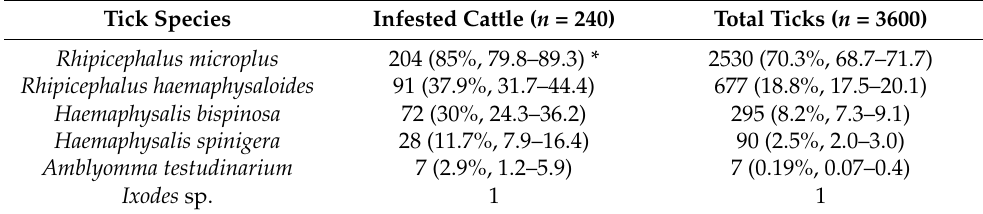
Table 3. Tick species sampled from farm animals in Trashigang and Pema Gatshel districts, Eastern Bhutan (2019).